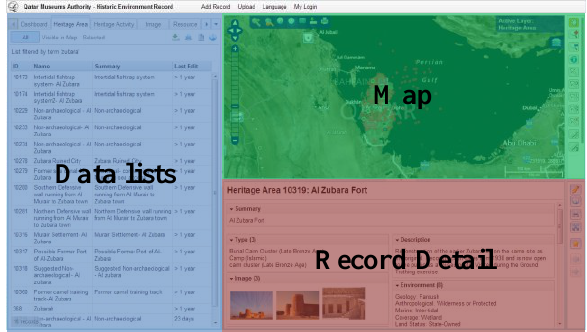
Figure 2. Layout of the QNHER 2.0 client application. The layout changes from right to left when switching to